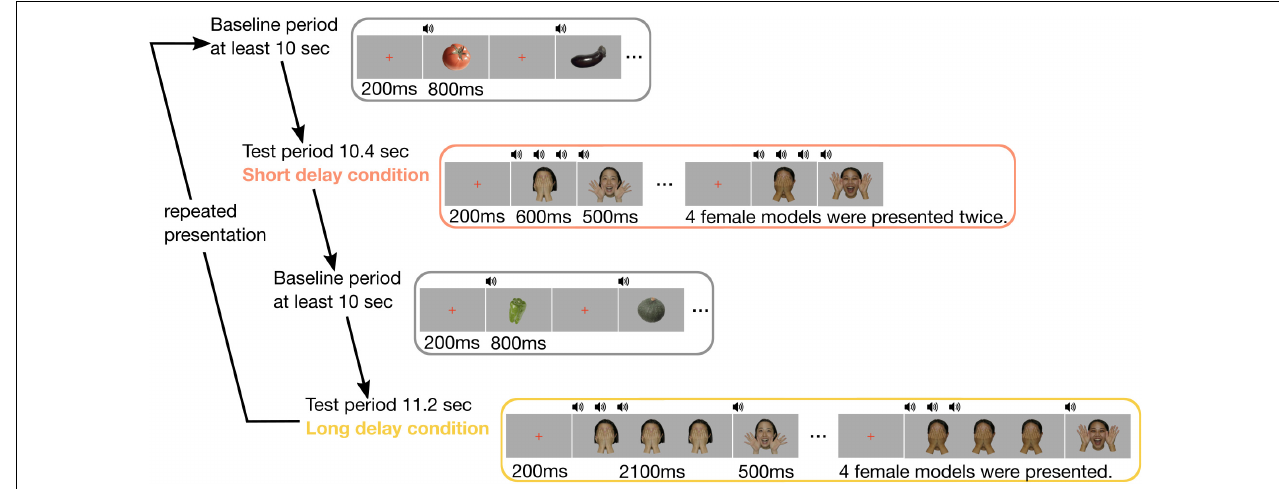
FIGURE 1 | Experimental procedure. In each trial, the baseline period comprised images of five vegetables, and its duration was for at least 10 s. The test period included images of four female faces. In the short delay condition, four female faces were presented twice, and its duration was 10.4 s. In the long delay condition, four female faces were presented, and its duration was 11.2